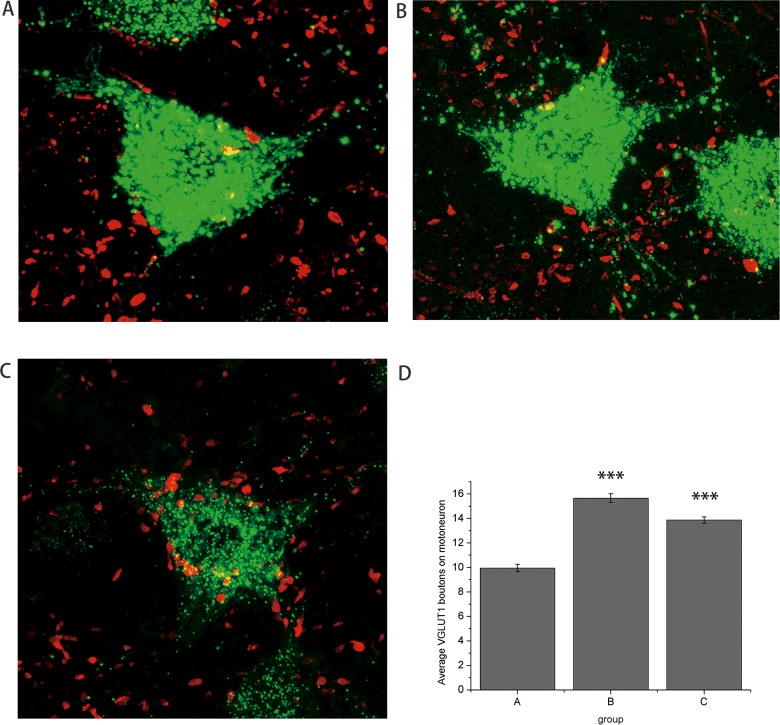
Quantification of VGLUT1 boutons on CTB labeled motoneuronsVGLUT1 positive boutons on CTB-labelled motoneurons. Confocal z-stack images from three groups showed CTB-labelled motoneurons (green) and VGLUT1 immunopositive boutons (red). Number of VGLUT1 positive boutons on motoneurons increased in the right side of L5 spinal cord in group B (C) compared with right L5 spinal cord in group A (A) and left L4 spinal cord in group C (B) (immunofluorescent stain, magnification ×630). (D) The average number of VGLUT1 positive boutons on motoneurons significantly increased in group B compared with that in group A (***P<0.001). After contralateral nerve root transfer, the average number of VGLUT1 positive boutons on motoneurons significantly reduced in group C compared with that in group B (***P<0.001).